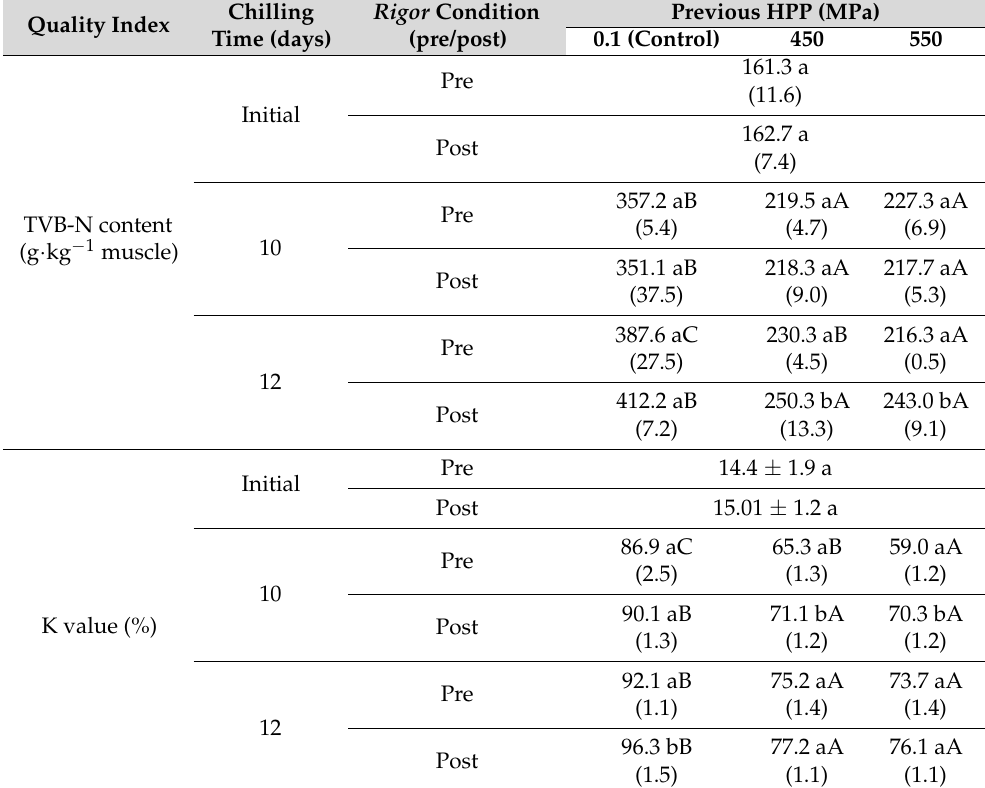
Table 4. Determination * of total volatile base-nitrogen (TVB-N) content and K value (%) in chilled palm ruff corresponding to different initial rigor conditions and previous high-pressure processing (HPP)